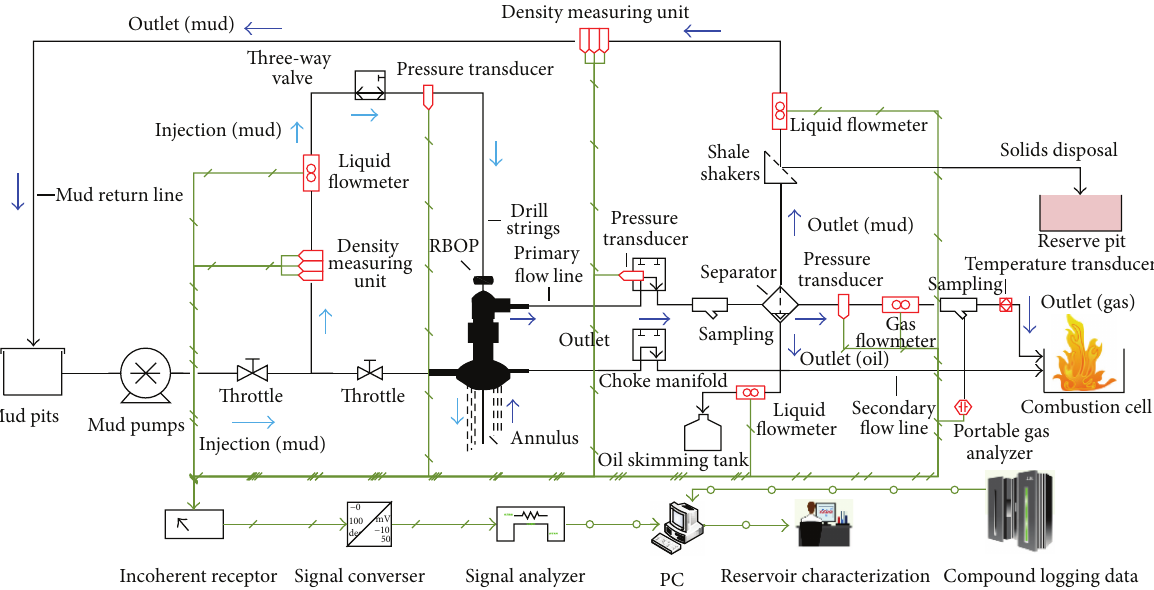
Figure 2: A schematic of the placement of the real-time data monitoring system for liquid-based underbalanced